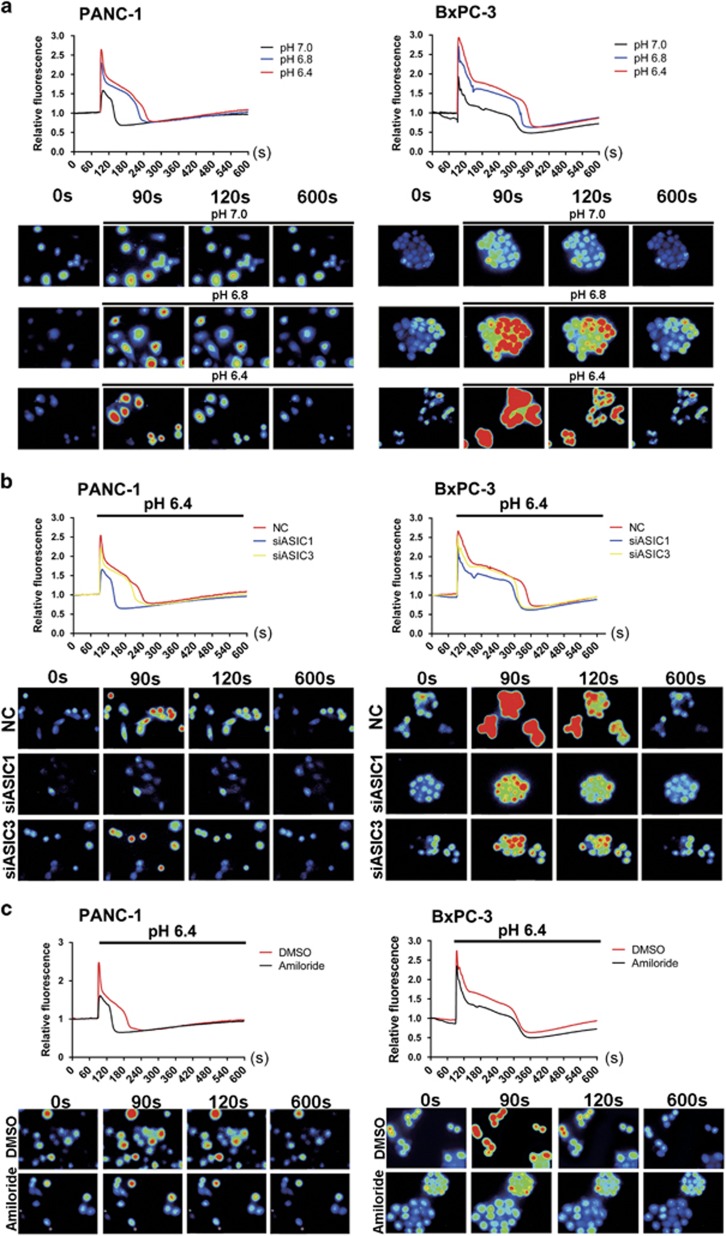
The acidity-induced elevation of [Ca2+]i is suppressed by inhibition of ASIC1 and ASIC3. (a) Calcium imaging detected dynamic change in [Ca2+]i when PANC-1 and BxPC-3 cells were treated with different acidic pH medium at 90 s. Pictures showed [Ca2+]i indicated by Fura-2/AM at indicated time. (b and c) After inhibition of ASIC1 and ASIC3 by siRNA or amiloride, calcium imaging detected dynamic change in [Ca2+]i of PANC-1 and BxPC-3 cells in acidic medium (pH 6.4). Pictures showed intracellular Ca2+ concentration indicated by Fura-2/AM at indicated time. Experiments were performed three times